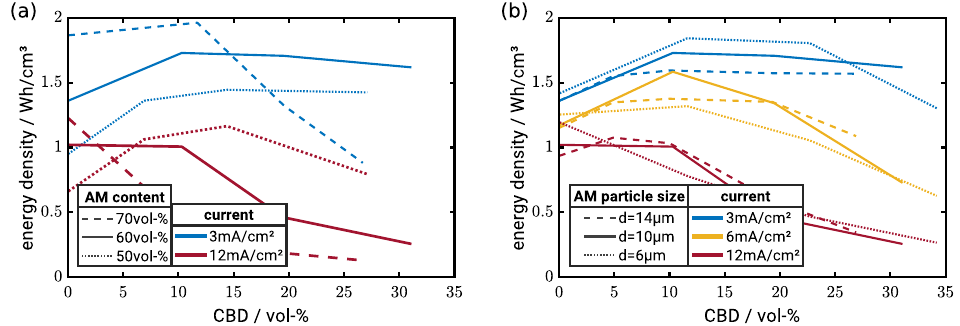
Figure 8. Energy density as a function of CBD content. ( a ) Variation of CAM content ( d 50 = 10µm). ( b ) Variation of particle size (60 vol-% CAM). Corresponding tabulated data sets can be found as the supporting information in Table